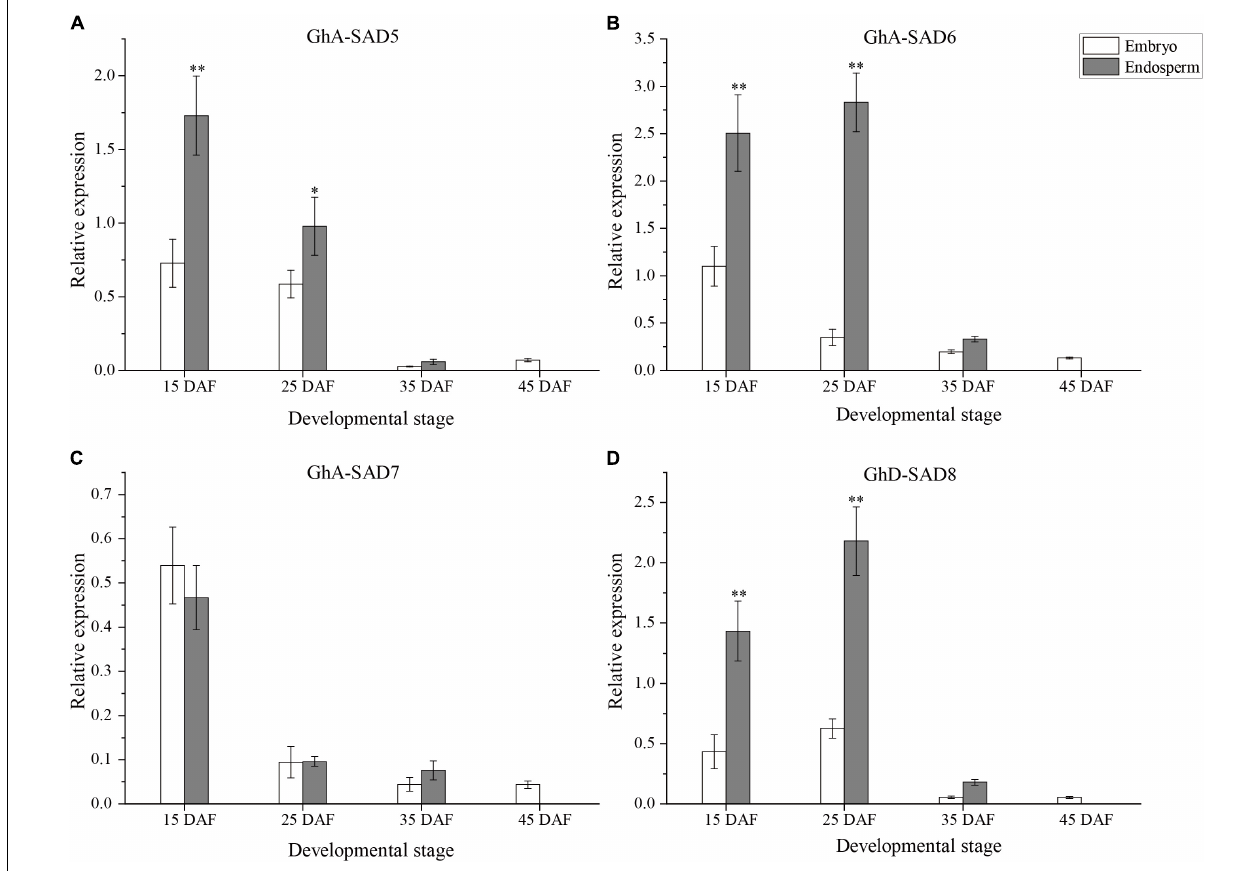
FIGURE 5 | Expression patterns of GhA-SAD5 (A) , GhA-SAD6 (B) , GhA-SAD7 (C) , and GhD-SAD8 (D) in developing cotton embryos and endosperms at 15, 25, 35, and 45 DAF. The same experimental and statistical methods are performed as in Figure 4